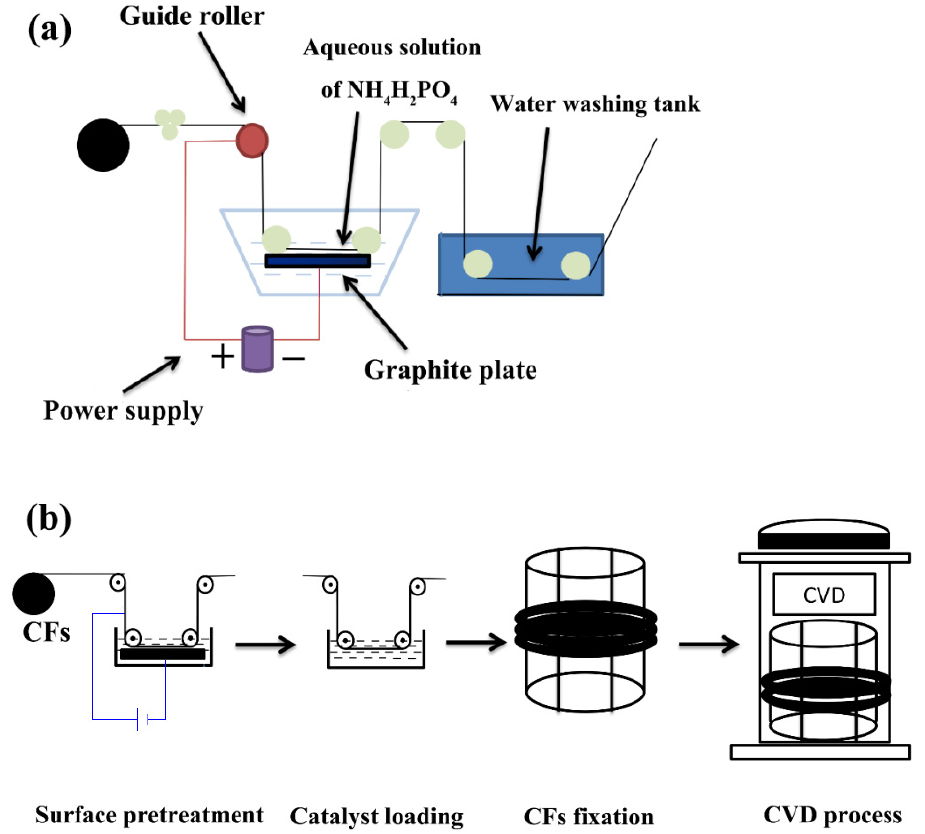
Figure 1. ( a ) EAO device, ( b ) Schematic diagram of CNTs grown on the CF